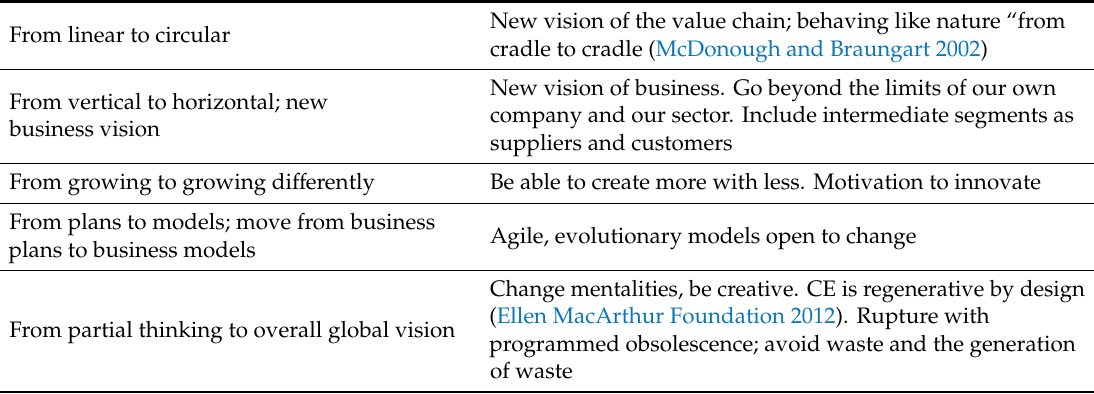
Table 1. New rules of the game.